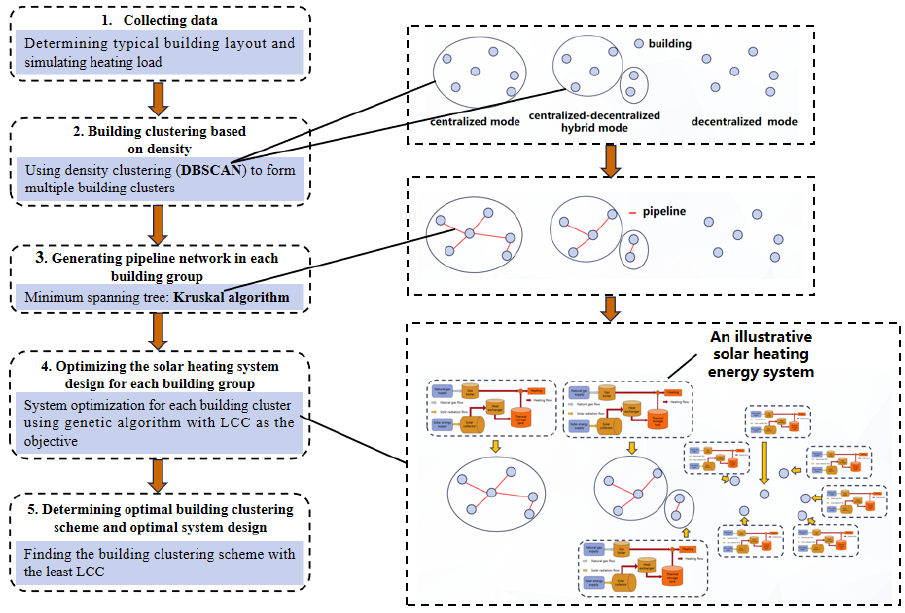
Figure 1. Methodology overview.